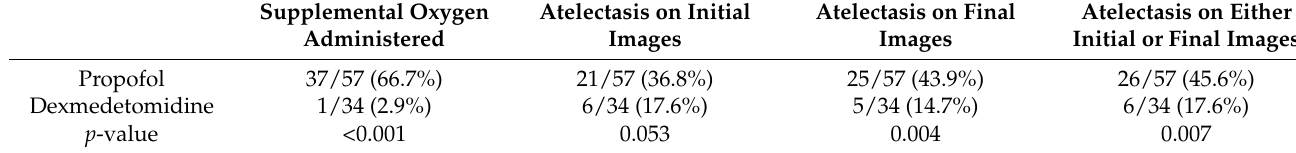
Table 2. Proportion of supplemental oxygen administered and rate of atelectasis occurrence according to the sedative agent used.